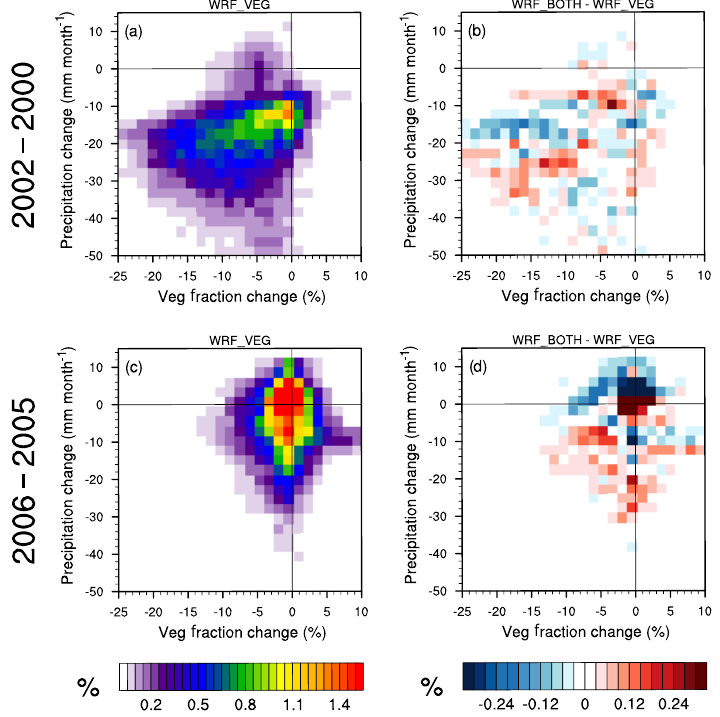
Figure 11. The bivariate joint probability distribution of the vegetation change and precipitation change in the (a) 2002 drought (2002– 2000) and (c) the 2006 drought (2006–2005). The change to this relationship caused by the addition of albedo changes in the WRF_BOTH experiment is shown in (b) and (d) , respectively.